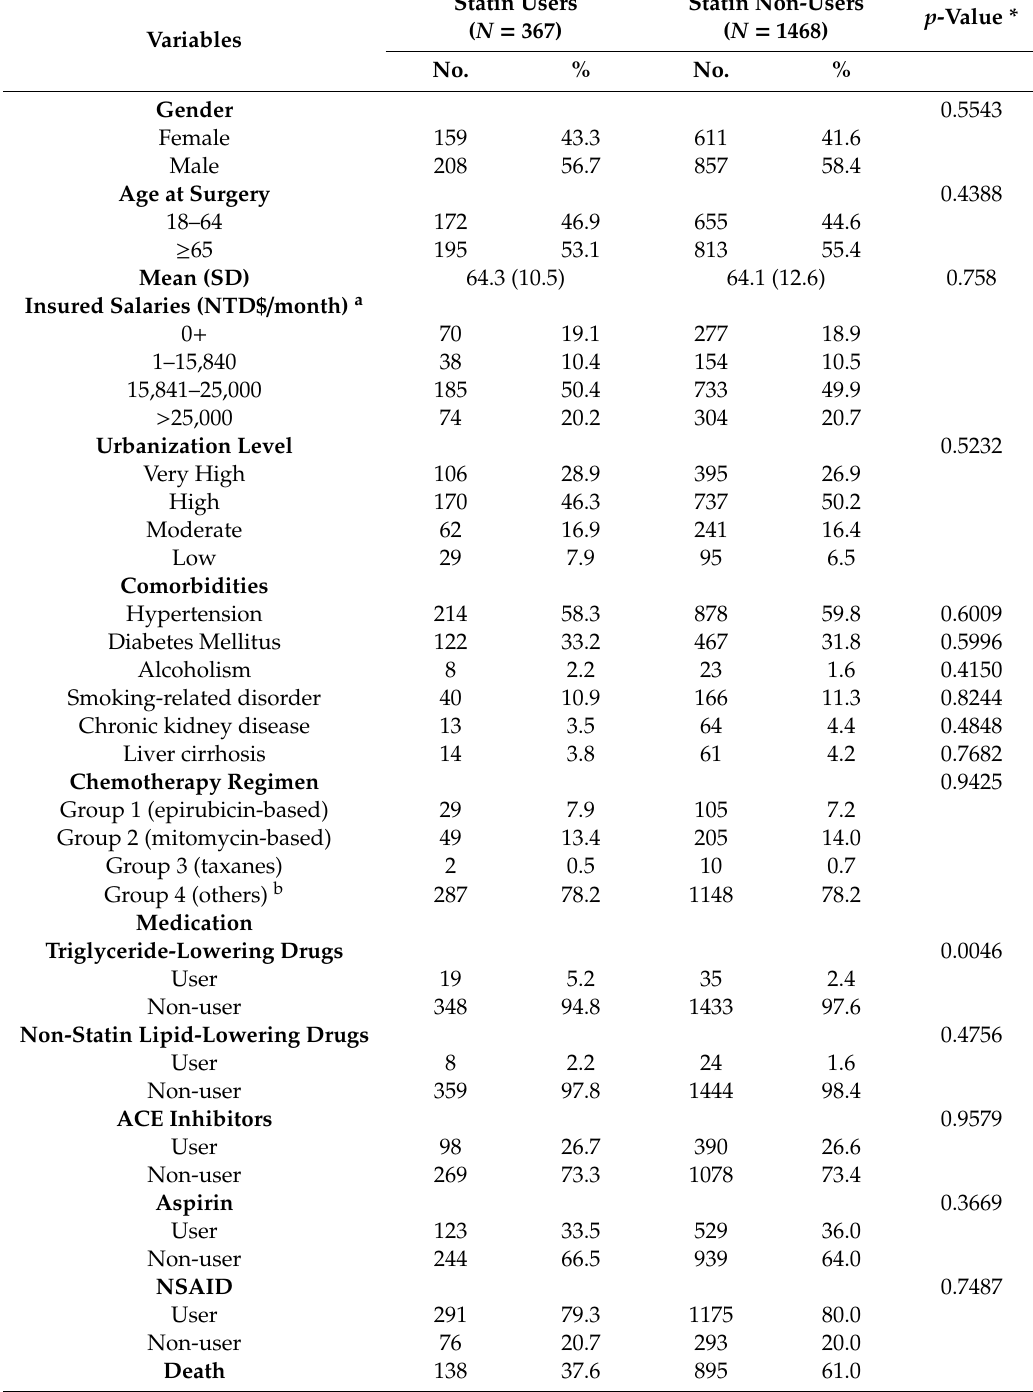
Table 1. Demographic characteristics of statin users and statin non-users among gastric cancer patients after surgery and adjuvant chemotherapy in Taiwan during 1999–2008 in the matched